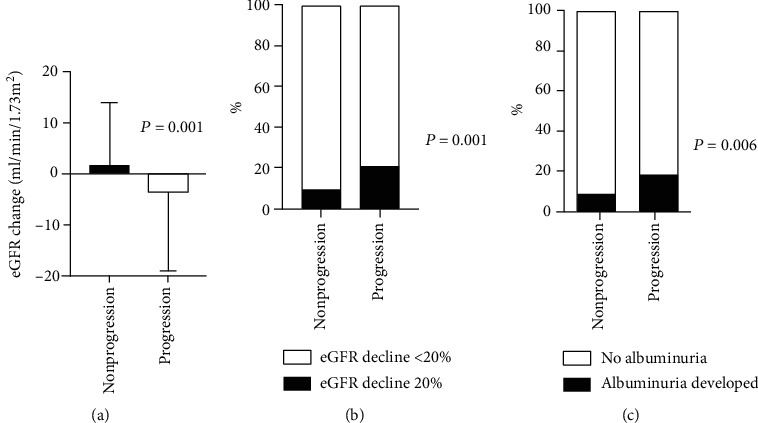
Changes of renal function in both groups. (a) Mean eGFR change. (b) Rate of ≥20% decline in eGFR during the follow-up period. (c) Albuminuria development. Abbreviation: eGFR: estimated glomerular filtration rate.